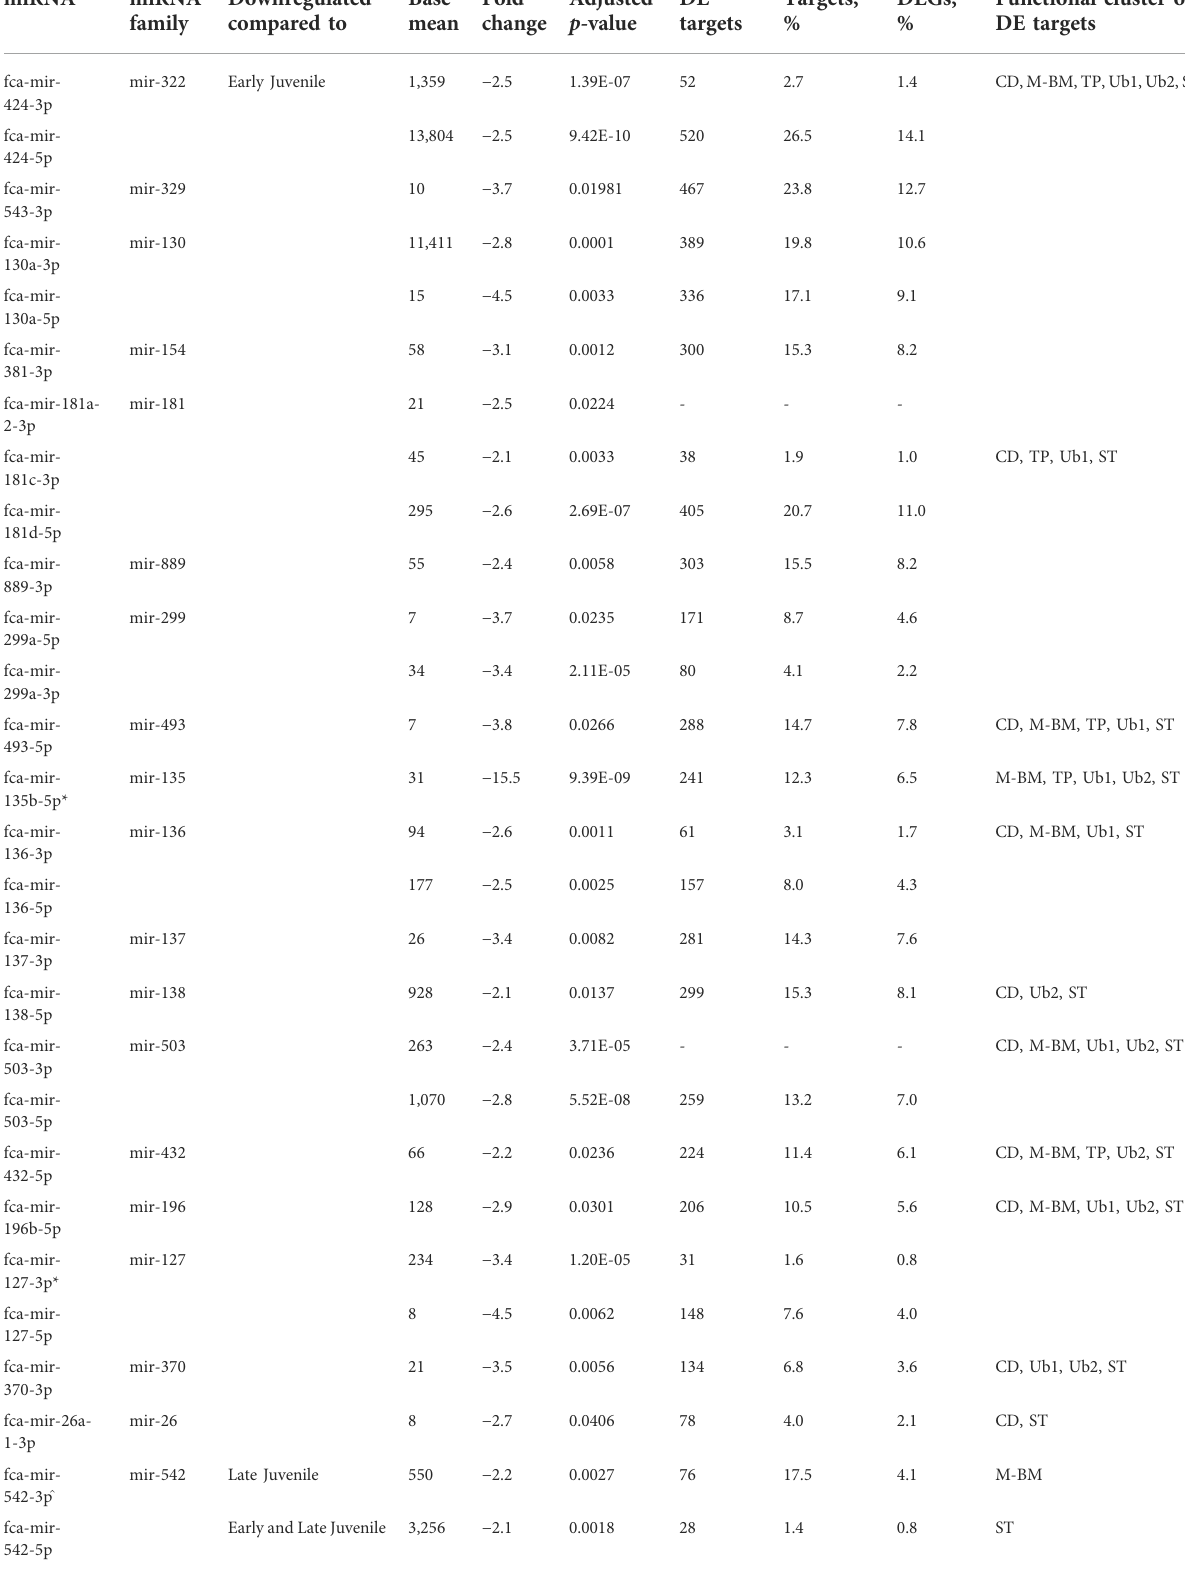
TABLE 2 Impact of downregulated miRNAs on upregulated mRNA in Adult compared to Early and Late Juvenile testis. miRNA miRNA Downregulated family compared to